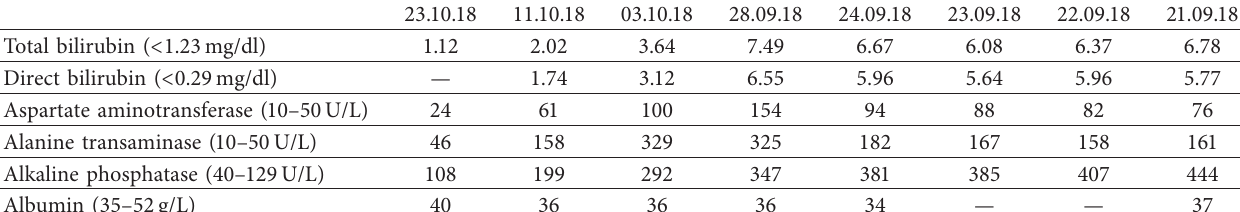
Table 1: Patient liver values from hospitalization up to the follow-up.